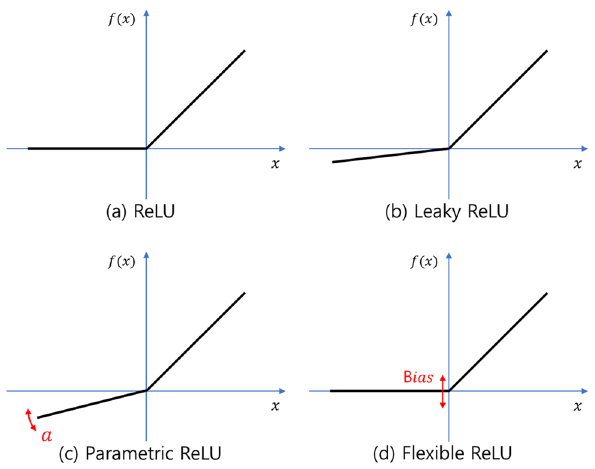
Fig. 1 Illustration of the original ReLU and its